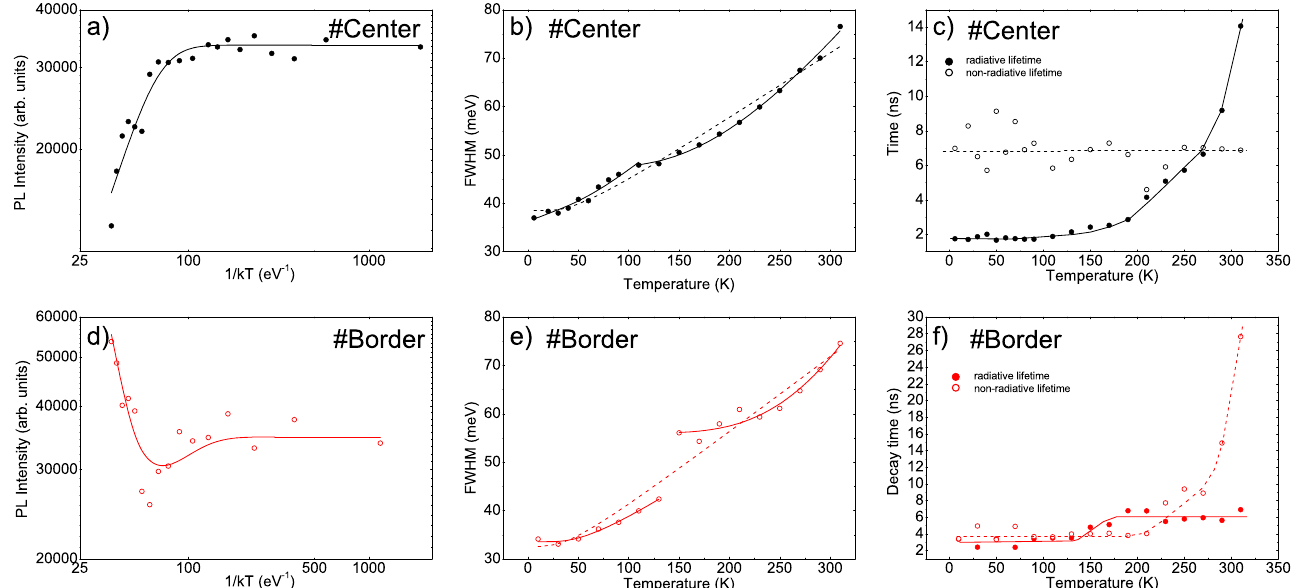
Figure 5. ( a ): Temperature dependence of the integrated PL intensity at the #Center point (dots). The line is the best fit curve obtained with Equation (1). ( b ): Temperature dependence of the FWHM of the PL spectra at the #Center point (dots). The dashed line is the best fit curve obtained with Equation (2) over the entire temperature range (Section 4.1), while the two continuous lines are the best fit curves for temperatures reaching up to 110 K and above 110 K (Section 4.2). ( c ): Temperature dependence of the radiative and non-radiative lifetimes at the #Center point obtained from Equations (3) and (4). The curves are for visual guidance. ( d ): Temperature dependence of the integrated PL intensity at the #Border point (dots). The line is the best fit curve obtained with Equation (5). ( e ): Temperature dependence of the FWHM of the PL spectra at the #Border point (dots). The dashed line is the best fit curve obtained with Equation (2) over the entire temperature range (Section 4.1), while the two continuous lines are the best fit curves for temperatures reaching up to 130 K and above 130 K (Section 4.2). ( f ): Temperature dependence of the radiative and non-radiative lifetimes at the #Border point obtained from Equations (3) and (4). The curves are for visual